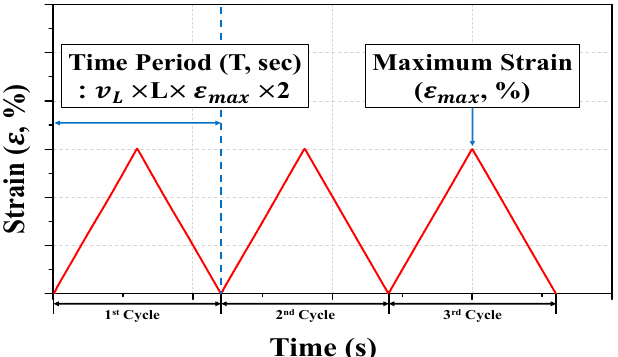
Figure 4. Loading protocol of the cyclic loading test.